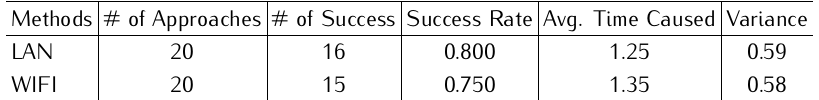
Table 4. Docking trials in di(cid:636)erent